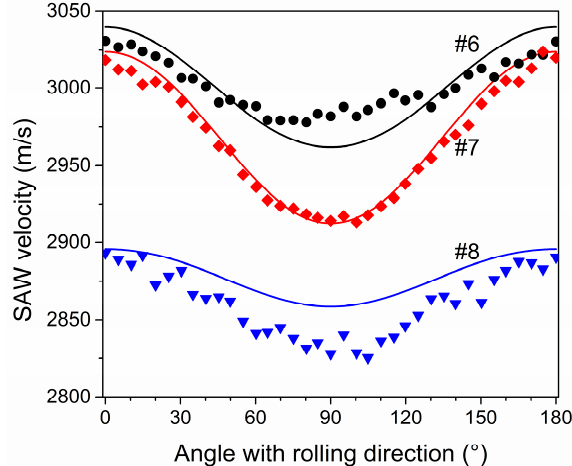
Figure 7. Evolution of the angular dependence of the SAW velocity: experimental data (the black dot for sample 6, the red diamond for sample 7 and the blue triangle for sample 8) and calculated results according to Equation (11) (the black solid line is sample 6, the red solid line is sample 7 and the blue solid line is sample 8).